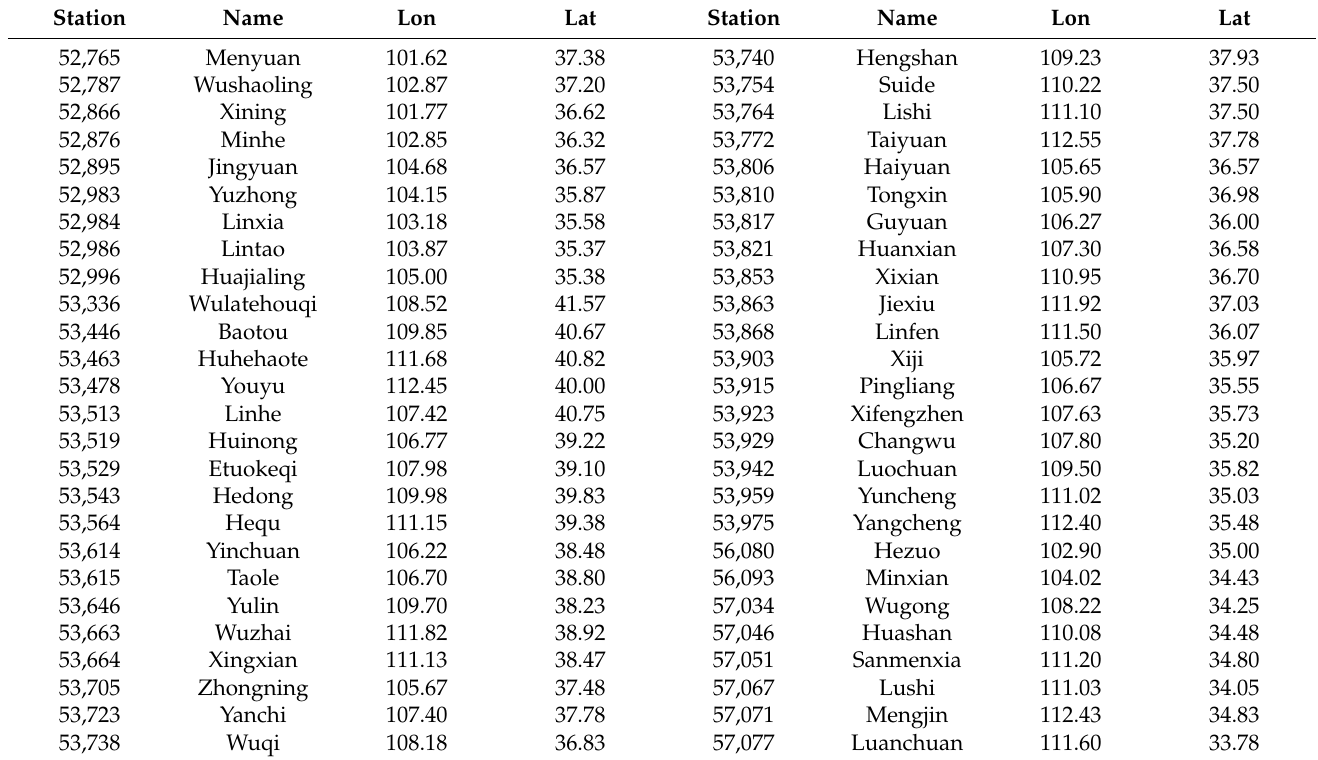
Figure 1. Geographical location of the Loess Plateau and distribution of meteorological stations and 22 sub-regions. Table 1. The names and coordinates of 52 meteorological